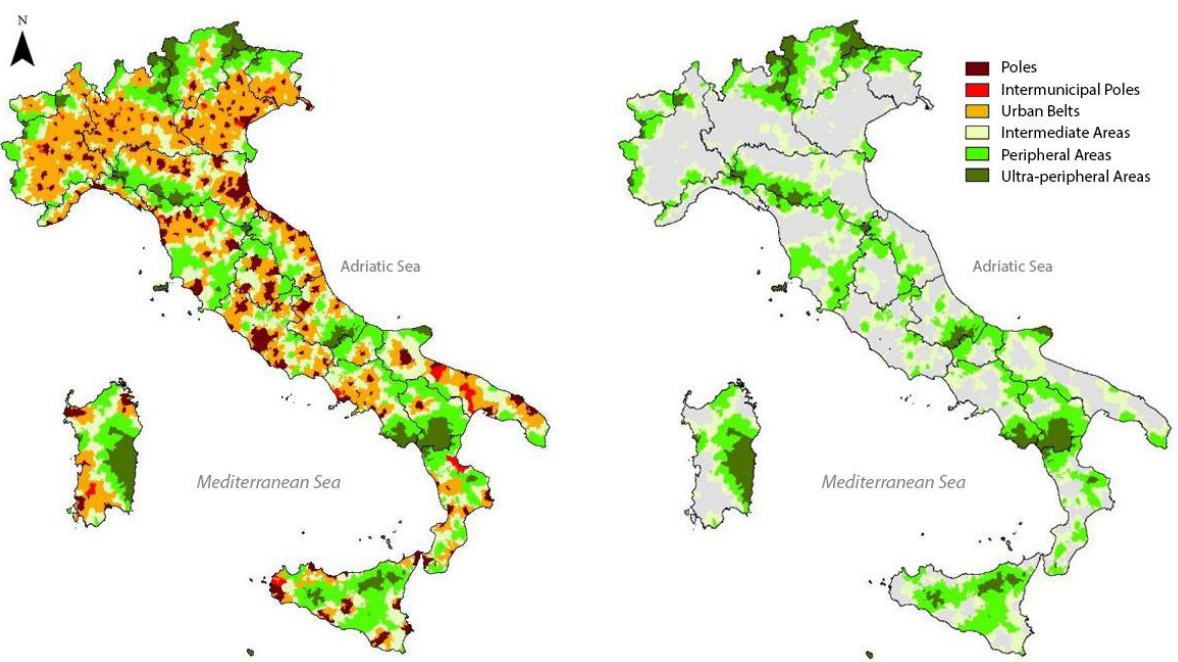
Figure 1. The Map of Strategy for Inner Areas (IA): general map ( left ) and the detail of inner areas ( right ) (Source: SNAI 2020).